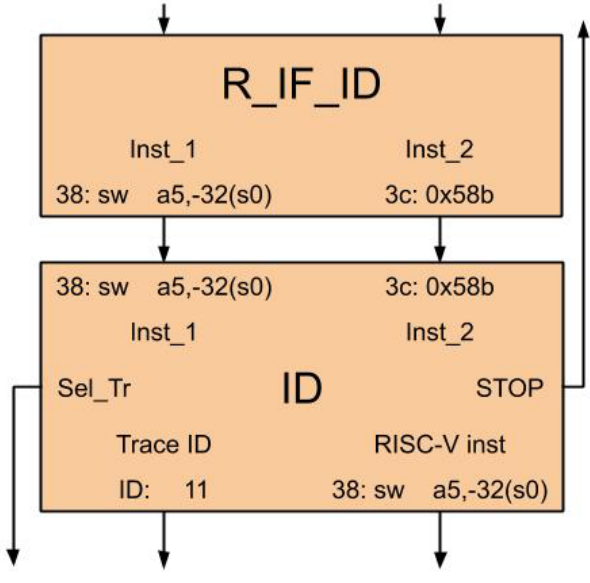
Figure 4. Trace’s instruction pair decodification stage.